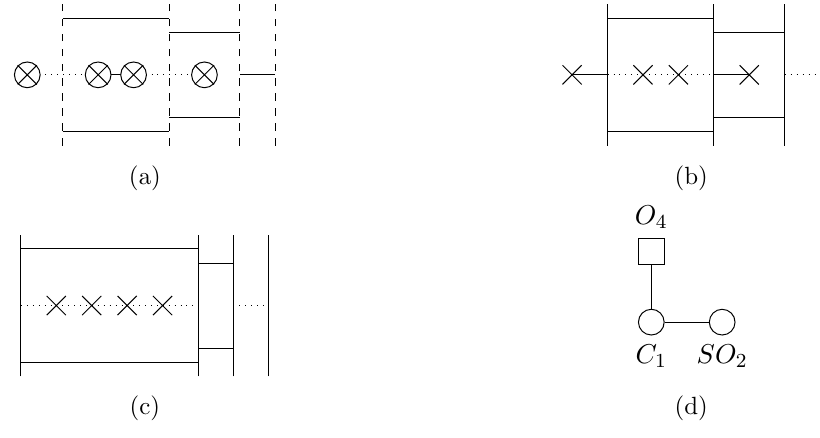
Figure 19. S-duality of the model with ~l d = (3 ; 3 ; 3 ; 3), ~l s = (1 ; 1 ; 1 ; 1) and rightmost orientifold plane O 3 (cid:0) . (a) Higgs branch brane con(cid:12)guration of the starting model. (b) Result of S-duality. (c) Result of performing the collapse transition that pulls the half D5-branes away from O 3 (cid:0) planes. This is necessary to read the corresponding quiver. (d) Quiver with a choice of SO 2 group in the rightmost node, this is related to the Lusztig’s Canonical Quotient (cid:22) A ( O of so (4) being trivial